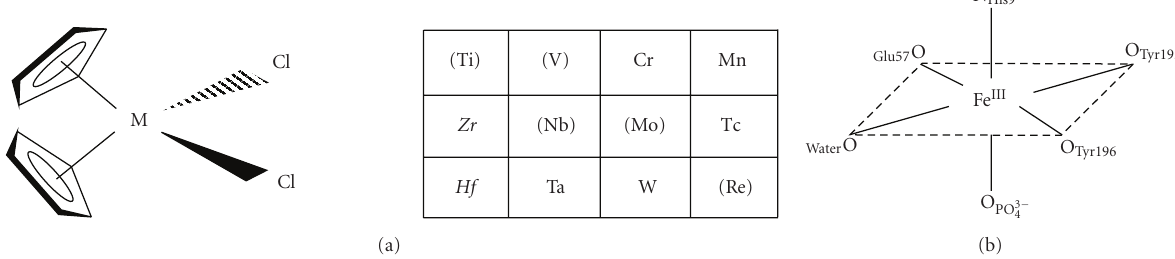
Figure 1: (a) Metallocene dihalides with antitumor activity. Key: (M) = maximum activity; M = sporadic activity; M = no activity. (b) Fe III binding sites in bacterial ferric ion-binding proteins ( Neisseria gonorrhoeae or Haemophilus influenzae